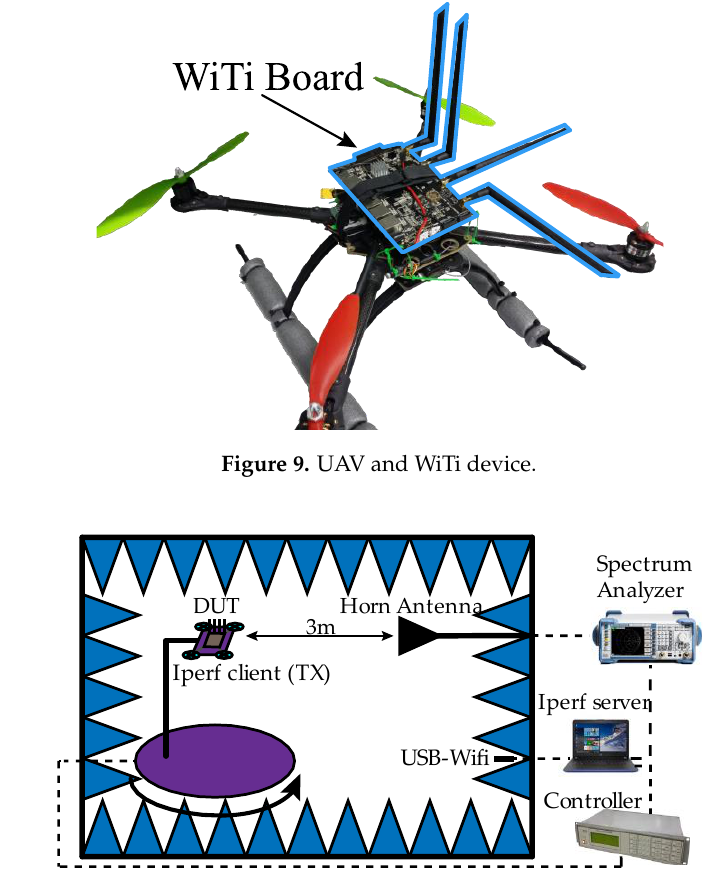
Figure 10. Experimental testbed elements (DUT ≡ Device Under Test ≡ UAV + WiTi device). Table 5. Summary of parameters and characteristics of the test bed.